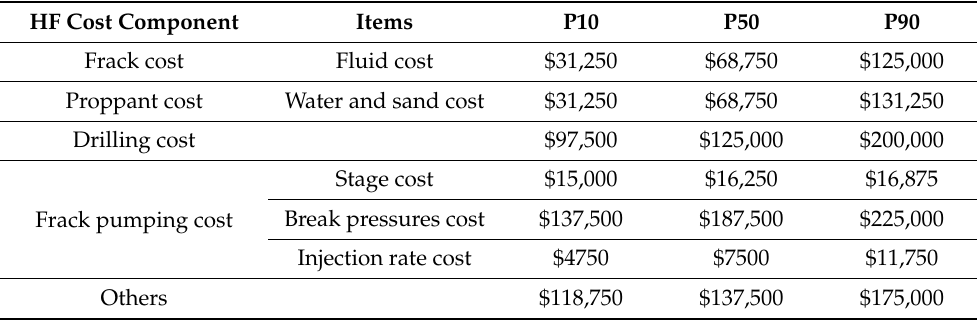
Table 2. P10, P50, and P90 of one borehole cost estimation with 500 m length for HF in block cave